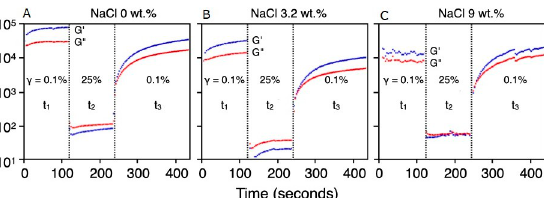
Fig 7. An amplitude sweep profile to measure the rheological properties of three calcite suspensions. Storage moduli G’ in blue, loss moduli G” in red. For details see text.